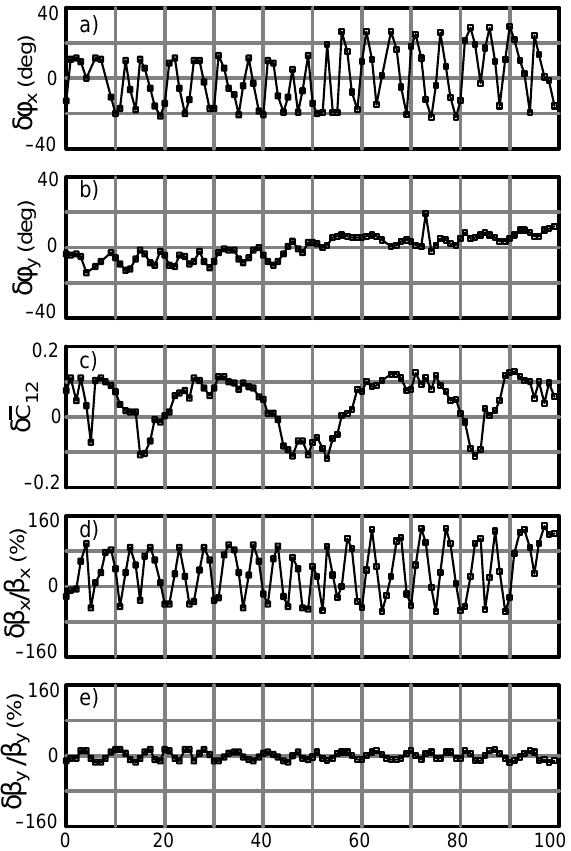
FIG. 6. Measurement after correcting the phase and coupling errors. This is to be compared to Fig. 5. Notice that the scales for all the graphs have been